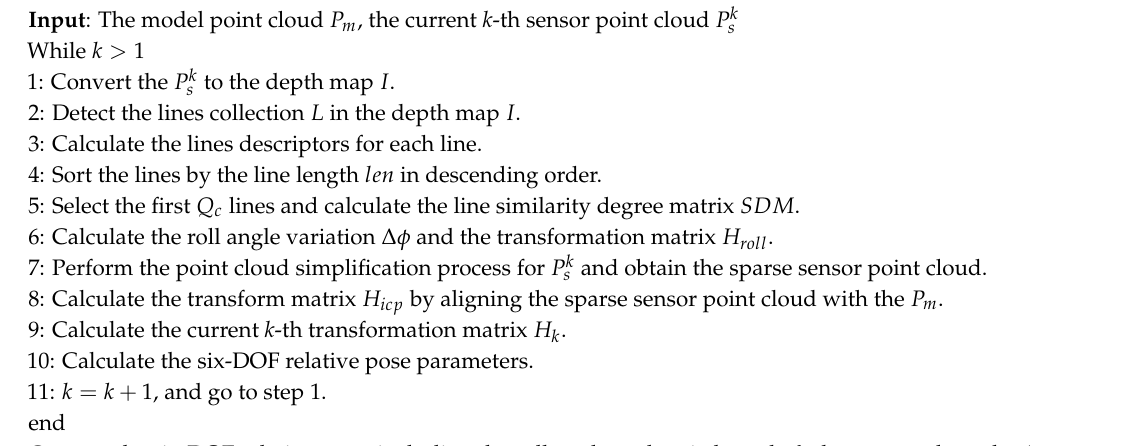
Algorithm 1: The Procedure of the Proposed Pose Tracking Method